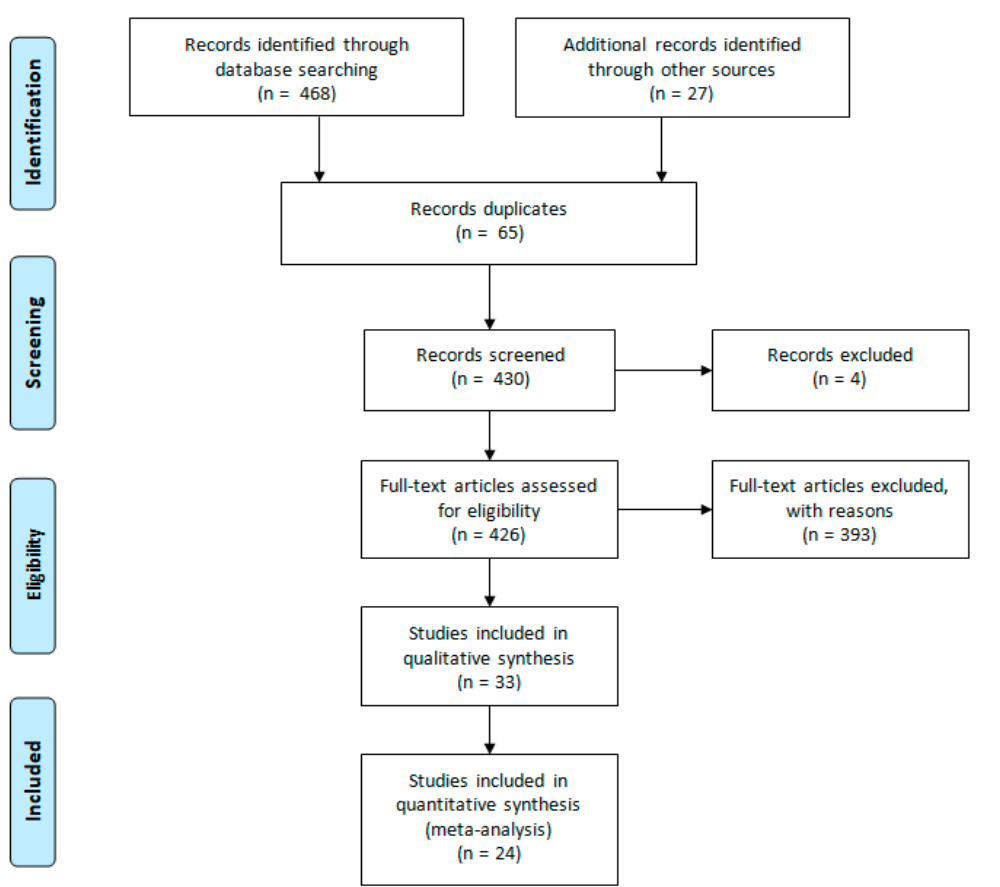
Figure 1. Mindfulness in the workplace: PRISMA flowchart with steps in article selection [39].